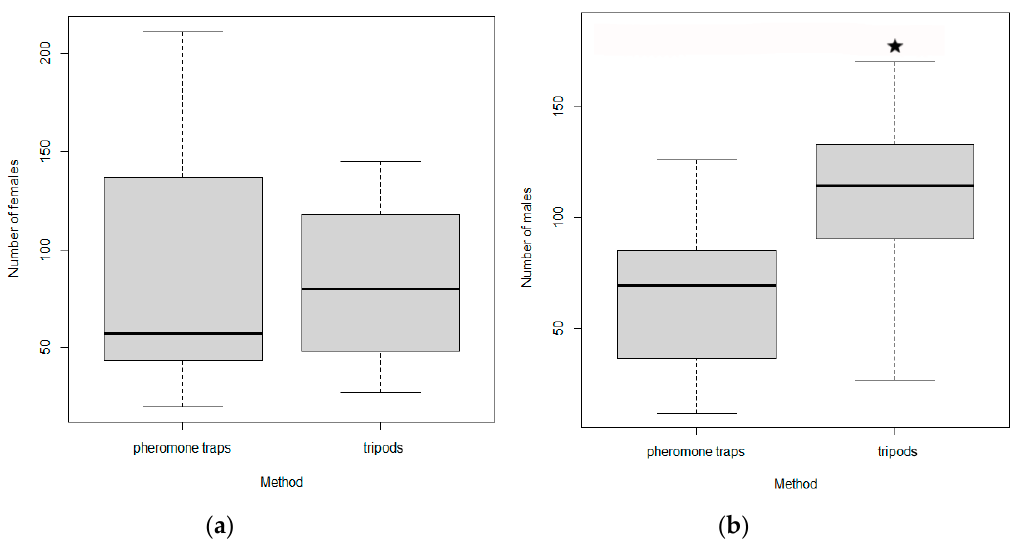
Figure 8. Number I. cembrae females ( a ) and males ( b ) captured in pheromone traps and tripods in experiment 4. The boxes indicate medians and interquartile range, and the whiskers indicate minimum and maximum values. * indicate significance at p < 0.05.